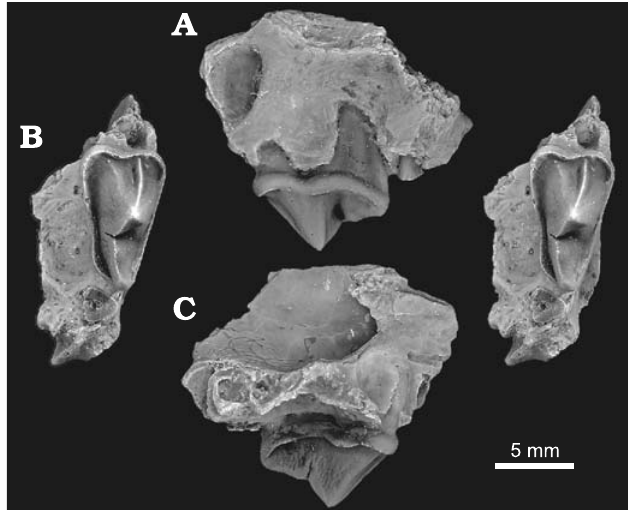
Fig. 5. Ailurid carnivoran Actiocyon parverratis sp. nov. from the Eastgate LF, basal-most unit of the Monarch Mill Formation, Barstovian (Miocene), Churchill County, Nevada, USA. UCMP 141911, paratype left maxilla frag- ment with P4 in labial ( A ), occlusal ( B , stereopair), and lingual ( C )